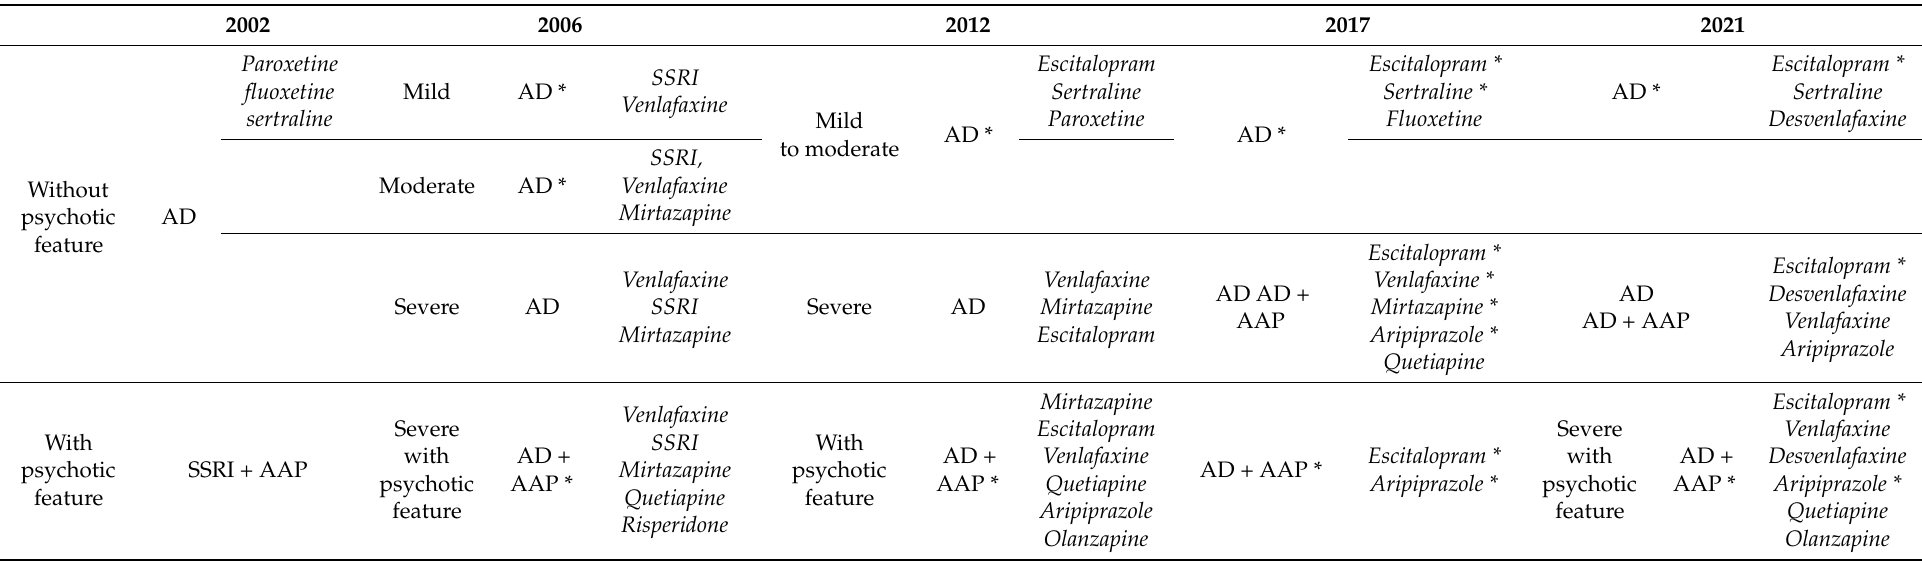
Table 2. First-line treatment strategies for major depressive episode of KMAP-DD.